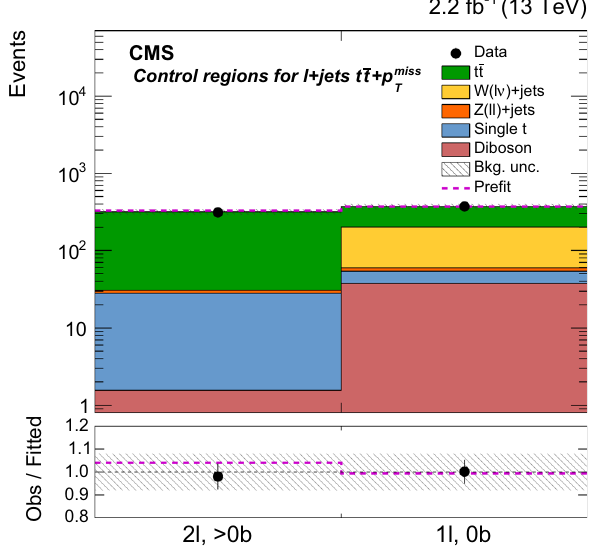
Fig. 4 Observed data, and prefit and fitted background-only event yields in the control regions associated with the (cid:5) + jets t t + p miss signal region. The 2 lepton, ≥ 0 b tag region (slA in Table 2) is used to constrain the dileptonic tt background in the (cid:5) + jets tt + p miss nal region, while the 1 lepton, 0 b tag control region (slB) constrains W + jets background. The lower panel shows the ratios of observed to fitted background yields. In both panels, the statistical uncertainties of the data are indicated as vertical error bars and the fit uncertainties as hatched bands. Prefit yields and the ratios of prefit to fitted background expectations are shown as dashed magenta histograms